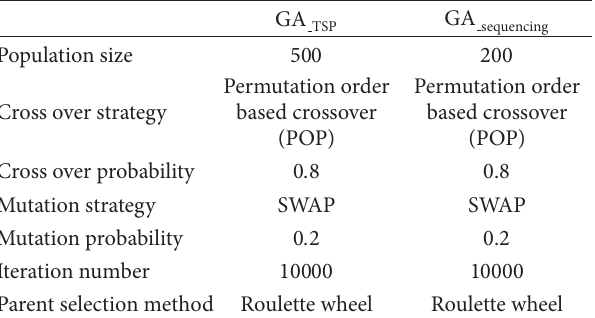
Table 6: GA control